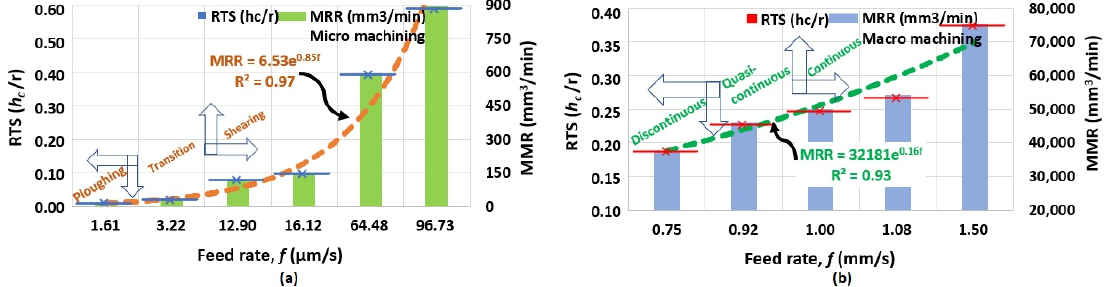
Figure 10. Combined effect of relative tool sharpness (RTS), feed rate and material removal rate (MRR) in ( a ) micro and ( b ) macro machining.